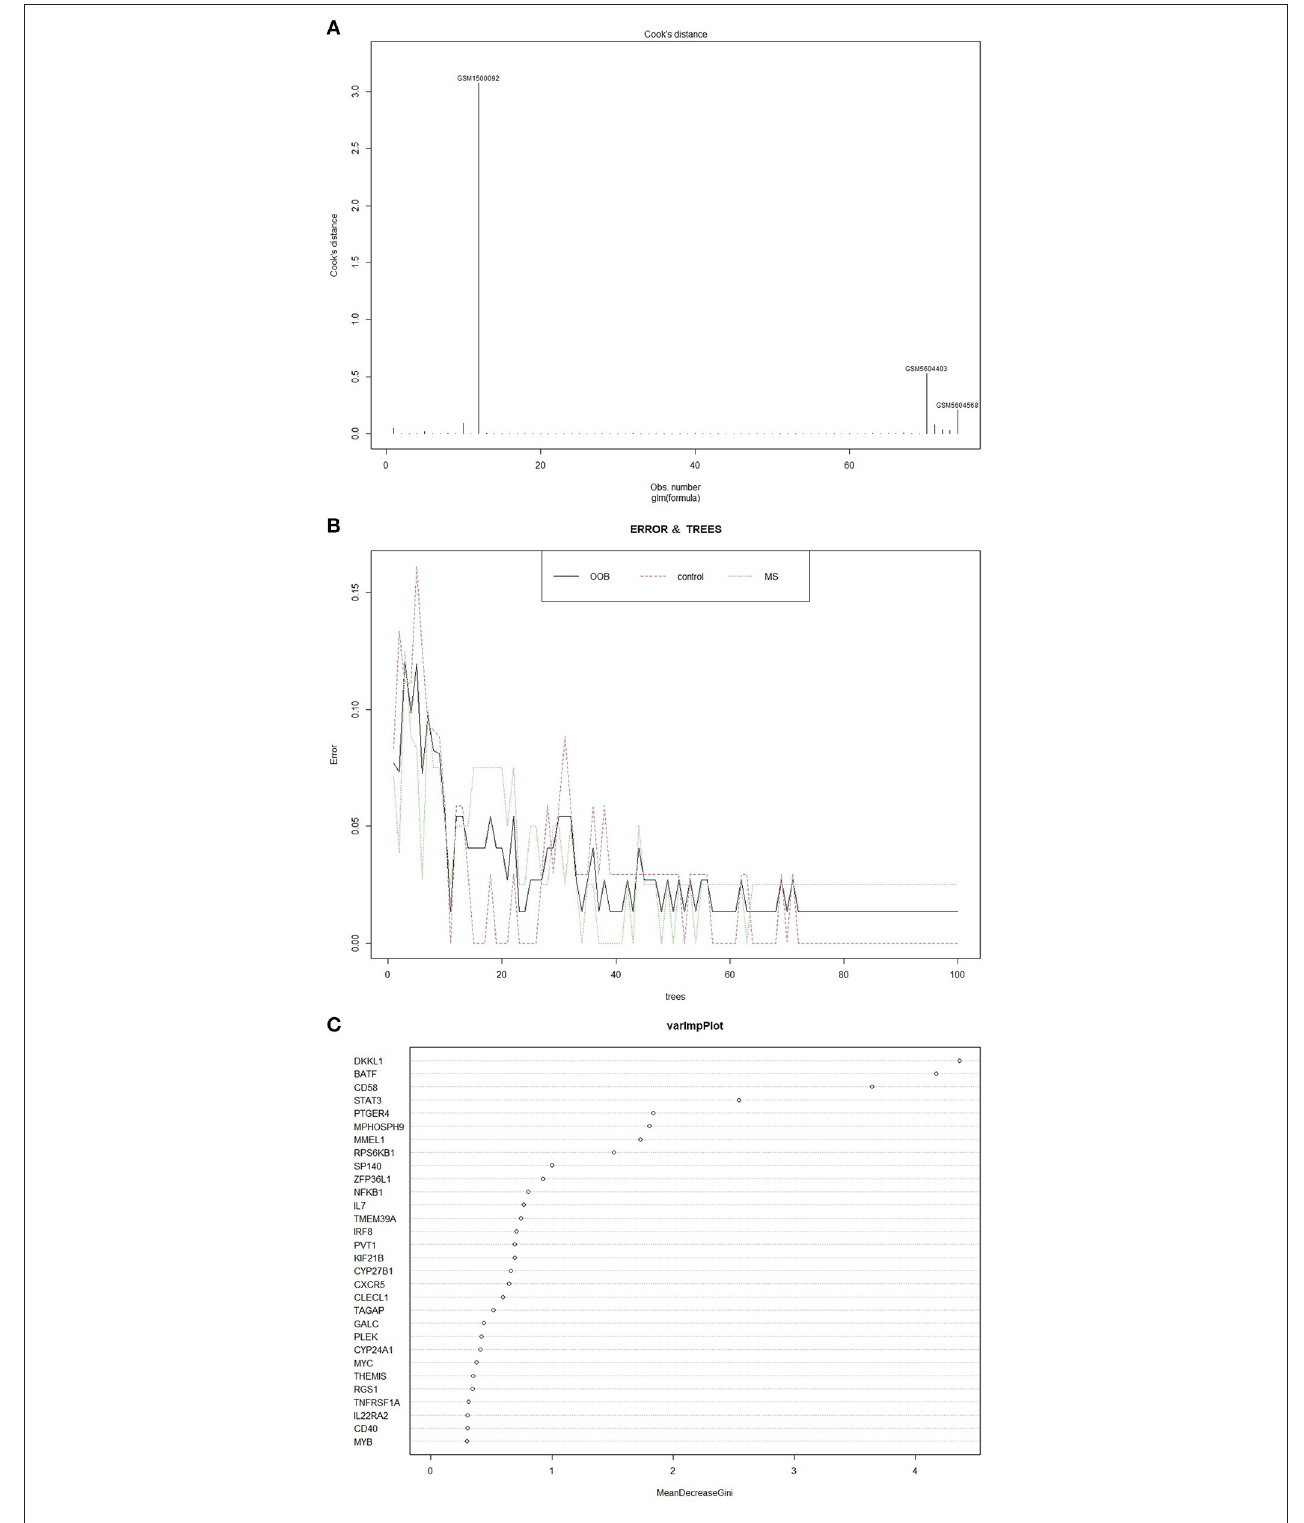
FIGURE 2 | (A) Cook’s Distance describes the influence of a single sample on the entire regression model. The greater the Cook’s distance, the greater the influence. (B) The relationship between the number of classification trees and the error in Random Forests. With the increase of the number of classification trees, the classification error gradually decreases, and the model gradually tends to be stable. (C) Gini index of predictors in the model, which reflects the importance of predictors.